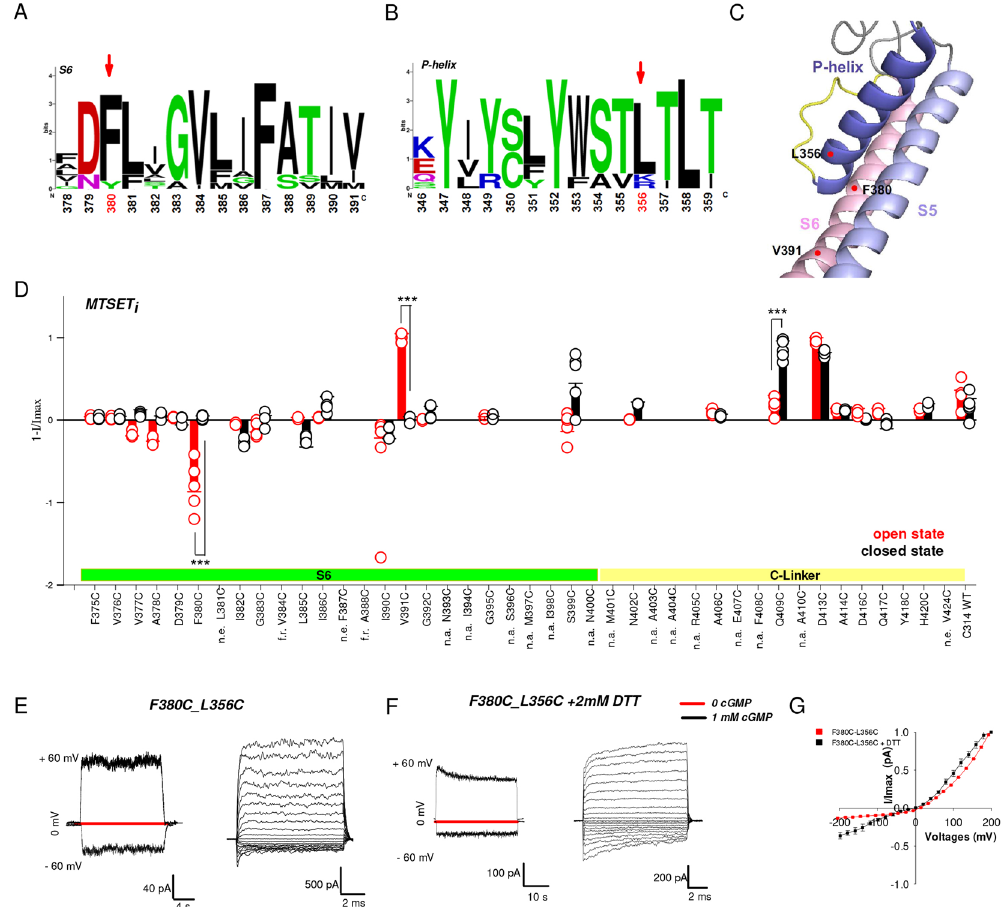
Figure 6. Cysteine scanning mutagenesis in S6 and C-linker and S-S bridges between S6 and the P-helix in the open state. ( A , B ) Web logo analysis of S6 ( A ) and P-helix ( B ) in CNG channels based on the alignment given in Supplementary Table S1. ( C ) Mapping CNGA1 residues on TAX-4 structure (PDB ID: 5H3O) shows the location of mutated residues in S6 and the P-helix. ( D ) Collected data of the effect of 2.5 mM MTSET i in the open (red) and closed (black) state in the S6 transmembrane domain and in the C-linker. ( E ) left: current recordings obtained in the absence (red) and in the presence of 1 mM cGMP (black) at ± 60 mV for mutant channels F380C_L356C. cGMP was added some seconds after setting the voltage command at ± 60 mV. The double mutant does not inactivate and it is gated by cGMP. Right: current recording obtained in the presence of 1 mM cGMP for mutant channels F380C_L356C, elicited by voltage steps from − 200 to + 200 mV. ( F ) as in ( E ) but in the presence of 2 mM DTT present in the patch pipette. ( G ) Macroscopic I–V relationships of F380C_L356C mutant channels in the presence (n = 3) and in the absence (n = 4) of DTT. The number (n) of experiments for different mutant channels in different states varies between 3 and 8 (for details see also Supplementary Table 2). (n.e.) represents mutant channels without expression, (n.a.) represents mutant channels with no experiments where the expression was too low. (f.r.) represents mutant channels with no experiments where the run-down was too fast. Significativity is shown only for mutants where the MTSET effect was > 30%. Unpaired two–tail T-test in d for F380C and V391C: t 10 = − 7,407, P < 0.001; t 4 = 25,158. Further statistical tests for these mutant channels and for all other tested mutants are reported in Supplementary Table